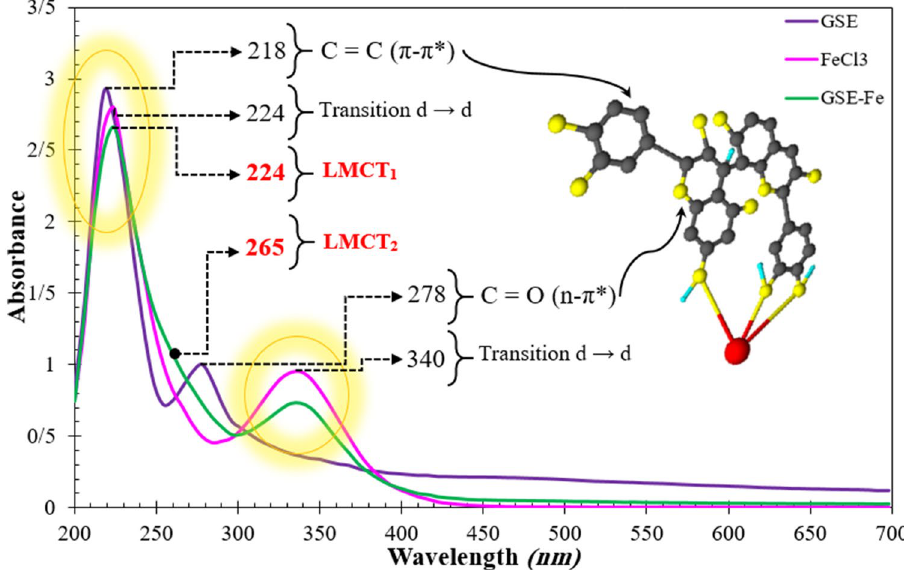
Figure 15. UV–Vis for GSE, metal cations (FeCl 3 ), and GSE complex with metal cations (GSE-Fe).